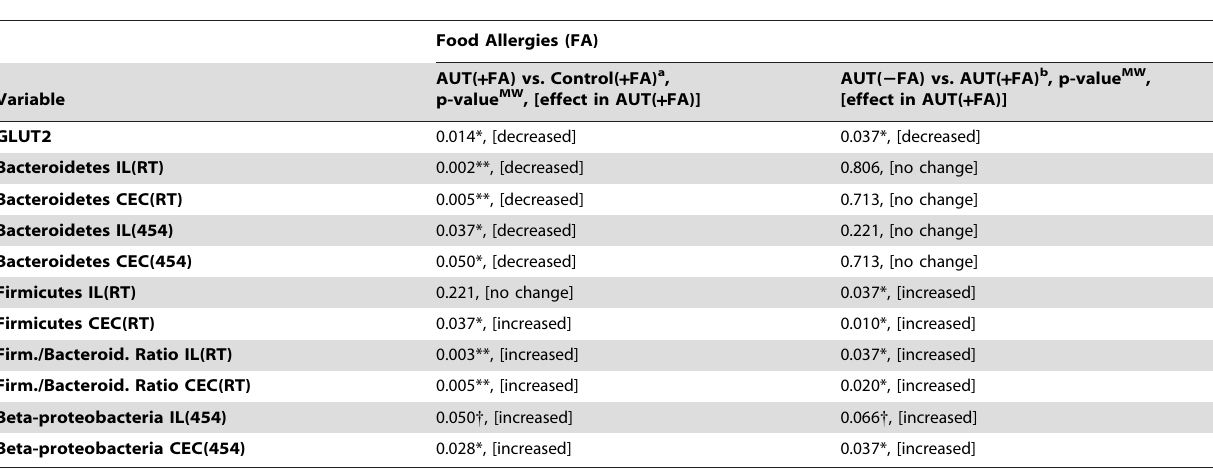
Table 5. Association of any food allergy (FA) with host gene expression and bacterial phylotypes in AUT-GI children.